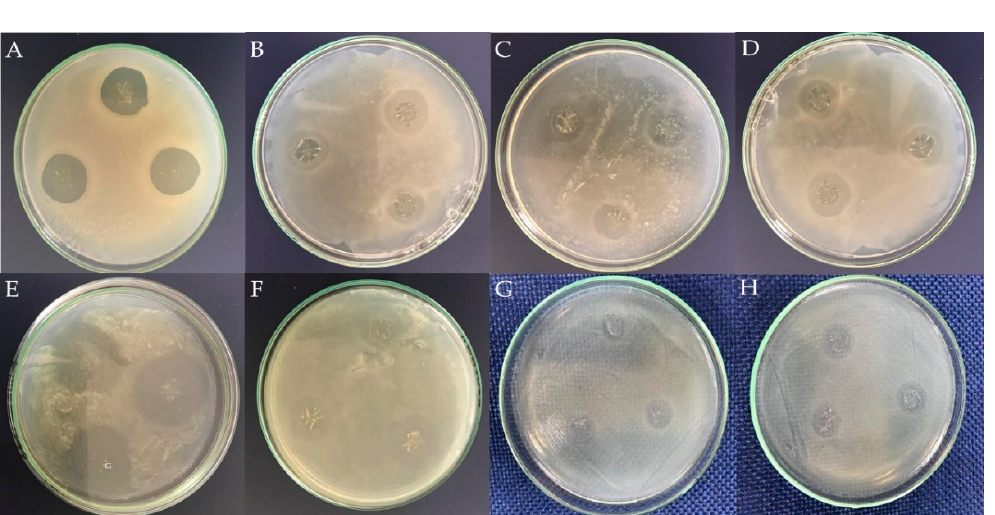
Figure 5. Inhibition zone for BAPS. ( A , B ) PVA/AMP 1.0% against Staphylococcus aureus and Escherichia coli . ( C , D ) PVA/ADD/AMP 1.0% against Staphylococcus aureus and Escherichia coli . ( E , F ) CHI/ADD/AMP 1.0% against Staphylococcus aureus and Escherichia coli . ( G ) PVA/CHI/ADD/AMP 0.3% against Staphylococcus aureus ( H ) PVA/CHI/ADD/AMP 1.0% against Staphylococcus aureus